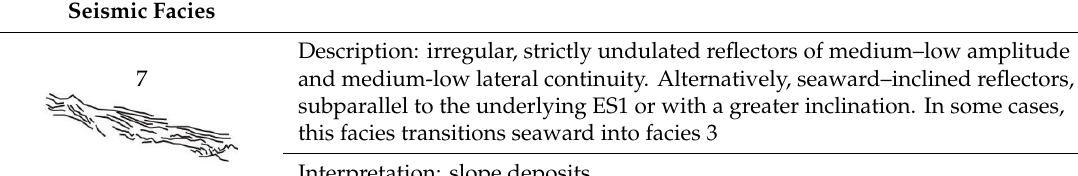
Table 2. Simplified sketch and short description of seismic facies 7, recognised within the UBSUs belonging to the TST in the Manfredonia Gulf area.